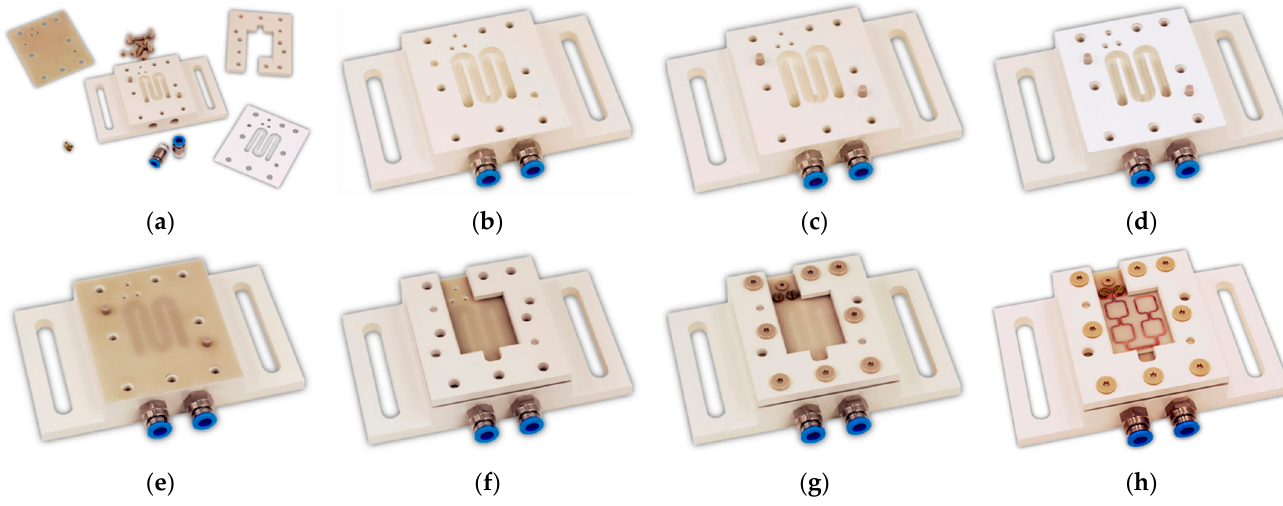
Figure 13. Assembly of the inductive bond module: ( a ) Individual component; ( b ) Base module with hose mounting; ( c ) Pins for component adjustment; ( d ) Water sealing; ( e ) Heat sink; ( f ) Bracket; ( g ) Screwing with mounting and contact screws; ( h ) Bonding module with Cu/AlN micro coil.